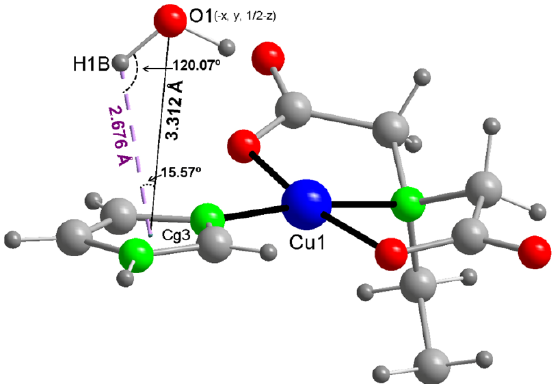
Figure 4. Crystal structure fragment representing the intermolecular (water)O1-H1B ··· π (Him) in- teraction. In brackets, assumable geometric parameters (d, Θ , Φ ) typically used to recognize this kind of interaction [33–38]: d(O) ··· Him(Cg, centroid) 3.31 (4.3) Å, θ (O1-Cg-H1B) 15.57 ◦ (<25 ◦ ), ϕ (O1-H1B ··· Cg) 120.1 (120–180 ◦ ).